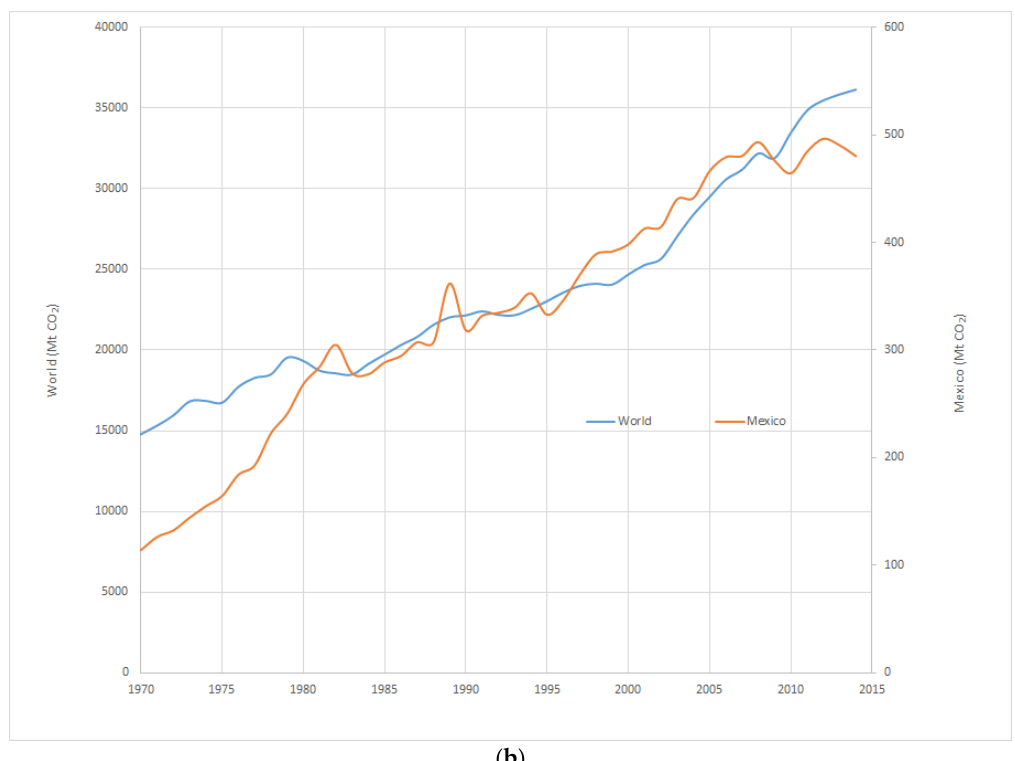
Figure 2. World and Mexico ( a ) CO 2 emissions per capita and ( b ) CO 2 total emissions. Prepared by the authors based on data from cited Reference [6].